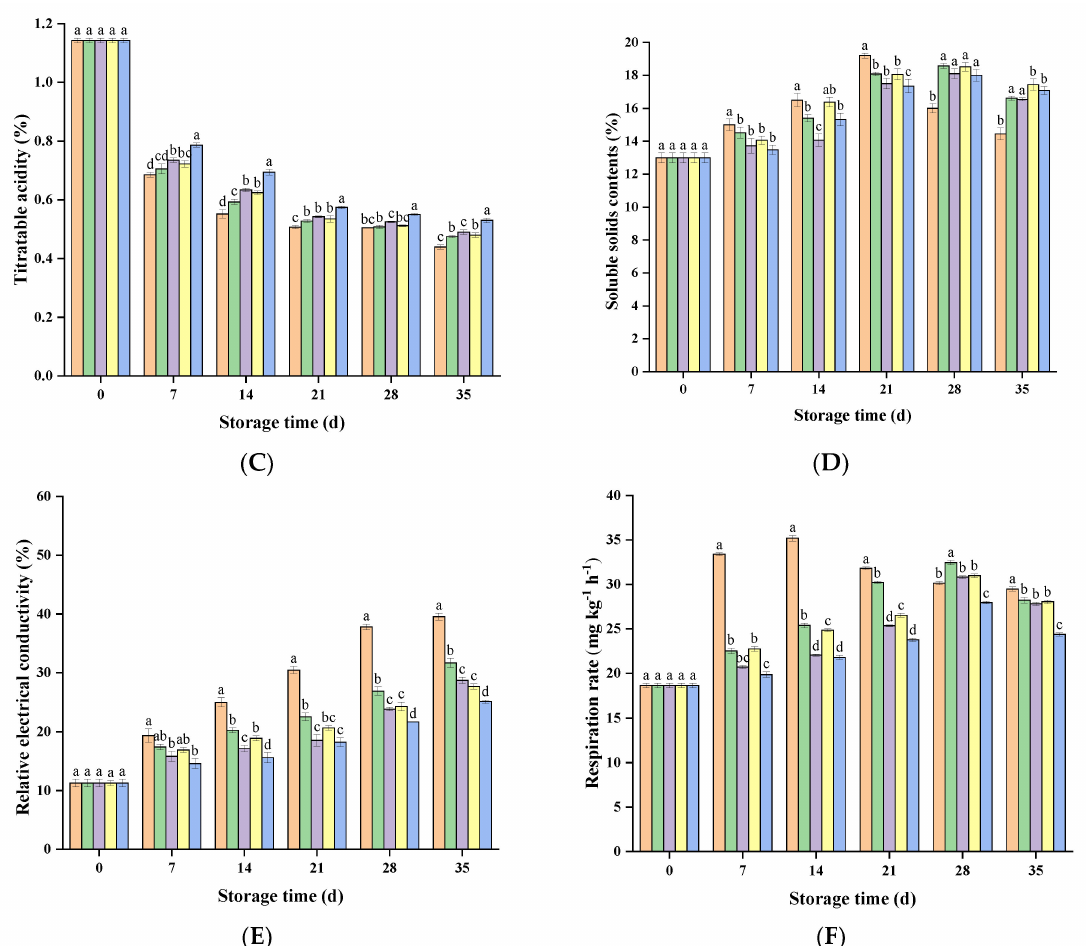
Figure 6. Effects of coatings of chitosan (CS) and CS grafted with chlorogenic acid (CGA-g-CS) on the weight loss ( A ), firmness ( B ), TA ( C ), SSC ( D ), relative electrical conductivity ( E ), and respiration rate ( F ) of apricots during storage at 1 ◦ C for 35 days. The vertical bar represents the standard deviation of the mean ( n = 3). Values followed by different letters indicate significant differences according to Duncan’s multiple range test ( p <